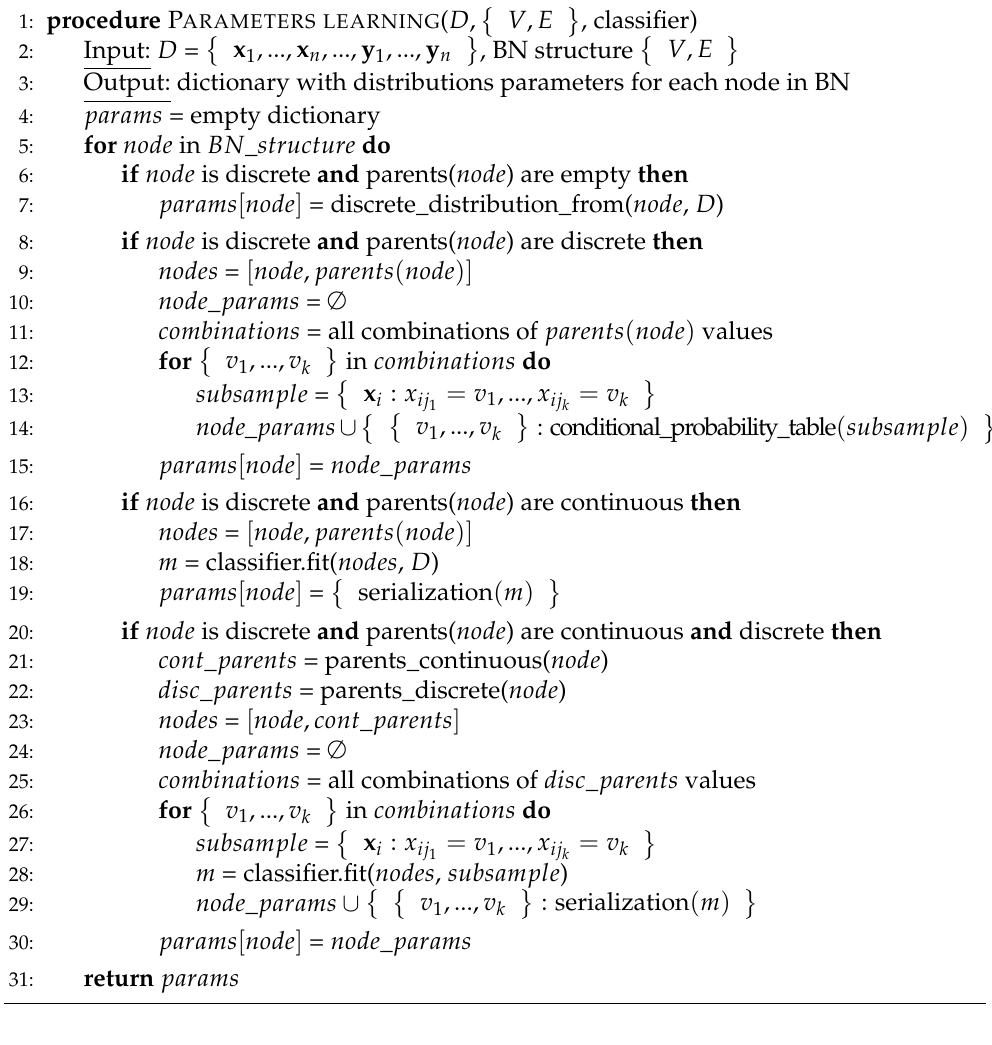
Algorithm 3 Parameter learning for discrete nodes in BNs with a classifier